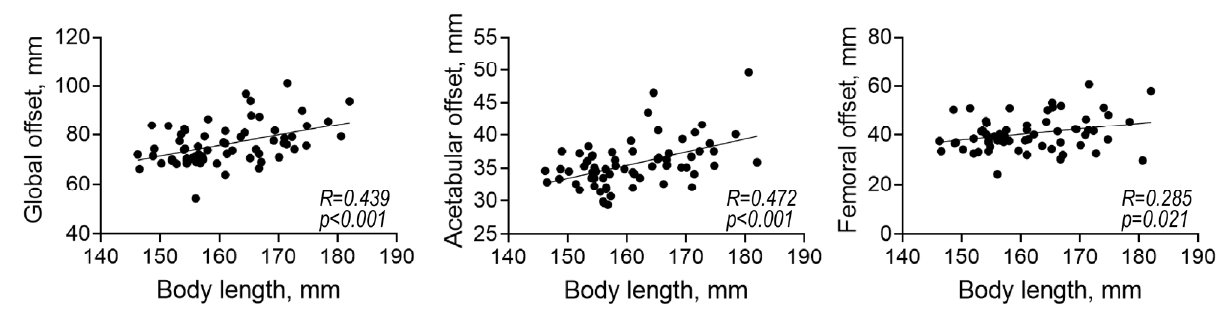
Figure 4. Correlations among the radiographic parameters and body length.